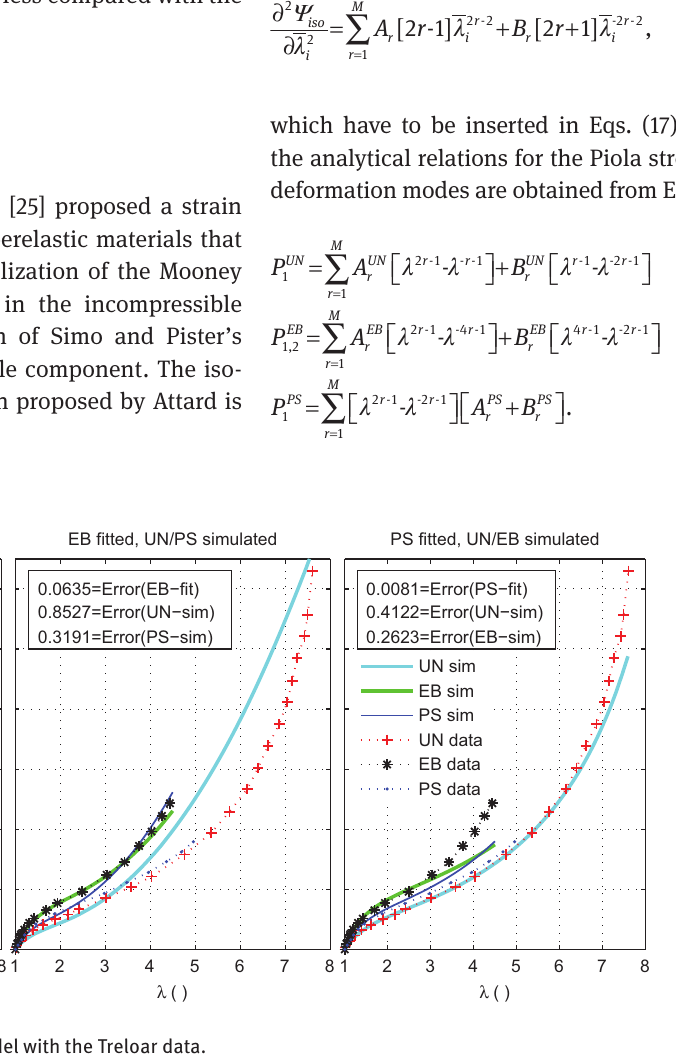
Figure 3 Comparison of the Shariff model with the Treloar data. The simulation quality is not satisfactory by the UN-fitted parameters (left), whereas both fitting and simulation in PS yield good results